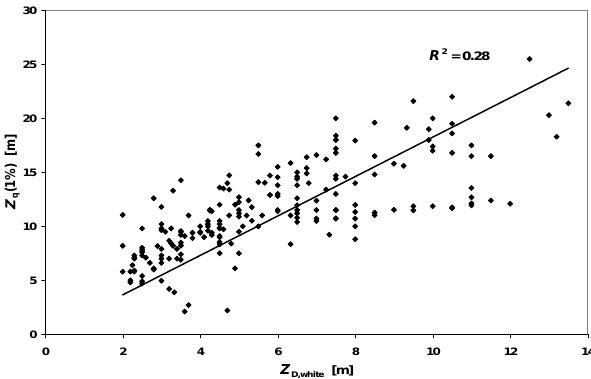
Fig. 8. The depth of the euphotic zone, estimated by the 1% level Z q (1%) of the surface quanta irradiance, as a function of the Secchi depth Z D,white . The best-fit line through the origin is Z q (1%) = 1.8 Z D,white